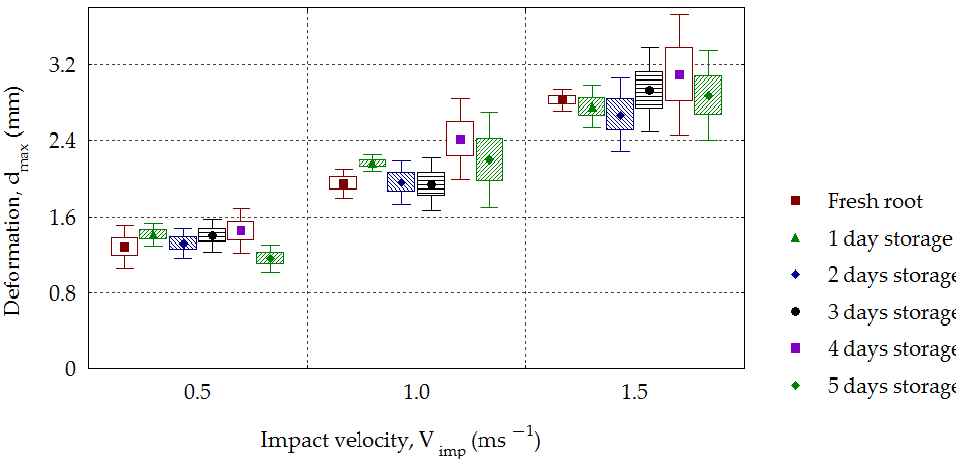
Figure 13. Dependence of the contact volume ( CV ) on the impact velocity ( V imp ) for the stored beets.